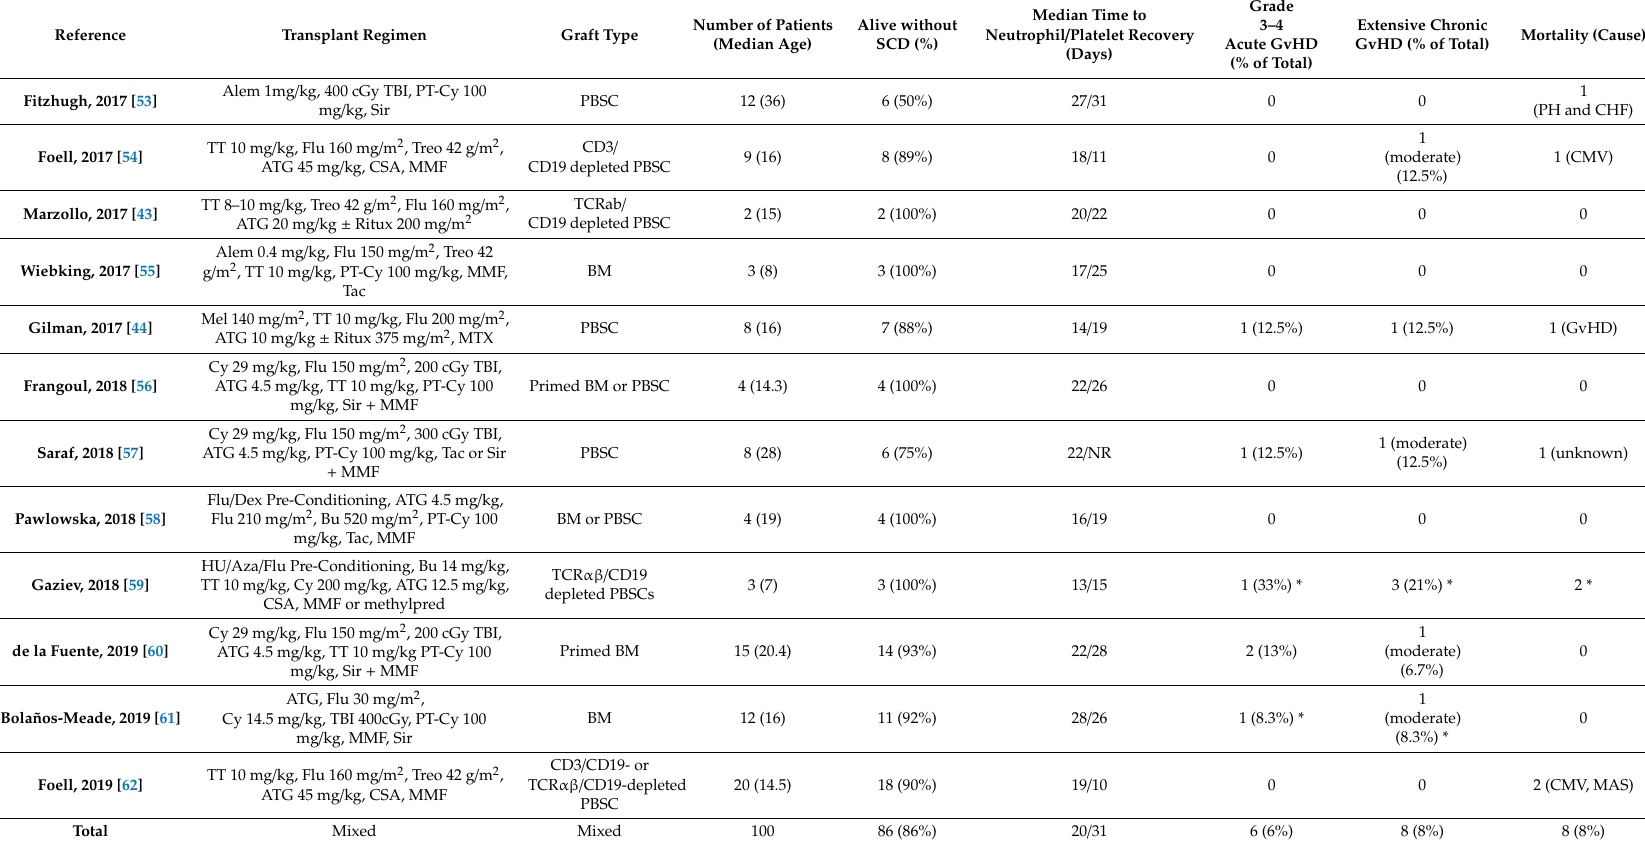
Table 4. Haploidentical hematopoietic stem cell transplantation (HSCT) for